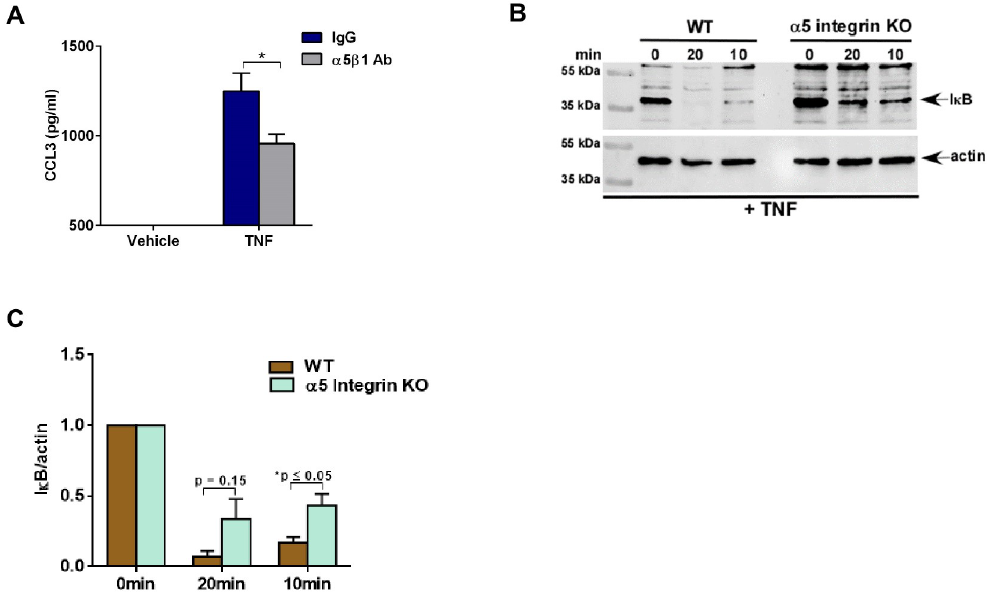
Fig 4. α 5 integrin is required for optimal TNF-mediated pro-inflammatory response and NF κ B activation. (A) Medium supernatant collected from BMDMs treated with TNF (100ng/ml) for 16h in the presence of either control IgG or α 5 β 1 blocking antibody (75 μ g/ml) was analyzed for CCL3 production by ELISA (n = 8; two independent experiments). (B) Cell lysate collected from WT and α 5 integrin KO HAP-1 cells treated with TNF (30ng/ml) for indicated time periods were subjected to western blot analysis to detect status of I κ B protein. The immunoblot is representative of three independent experiments with similar results. (C) Densitometric analysis of the western blot presented in Fig 4b. The densitometric quantification values for I κ B immunoblot represent the ratio of I κ B:actin and the fold-induction was calculated after normalizing with the control 0 min group. ELISA data are shown as Mean ± SEM. � p � 0.05 using a Student’s t-test. The densitometric values represent the mean ± SEM from three independent experiments. The p value shown in the figure was calculated using a Student’s t-test ( � p � 0.05).